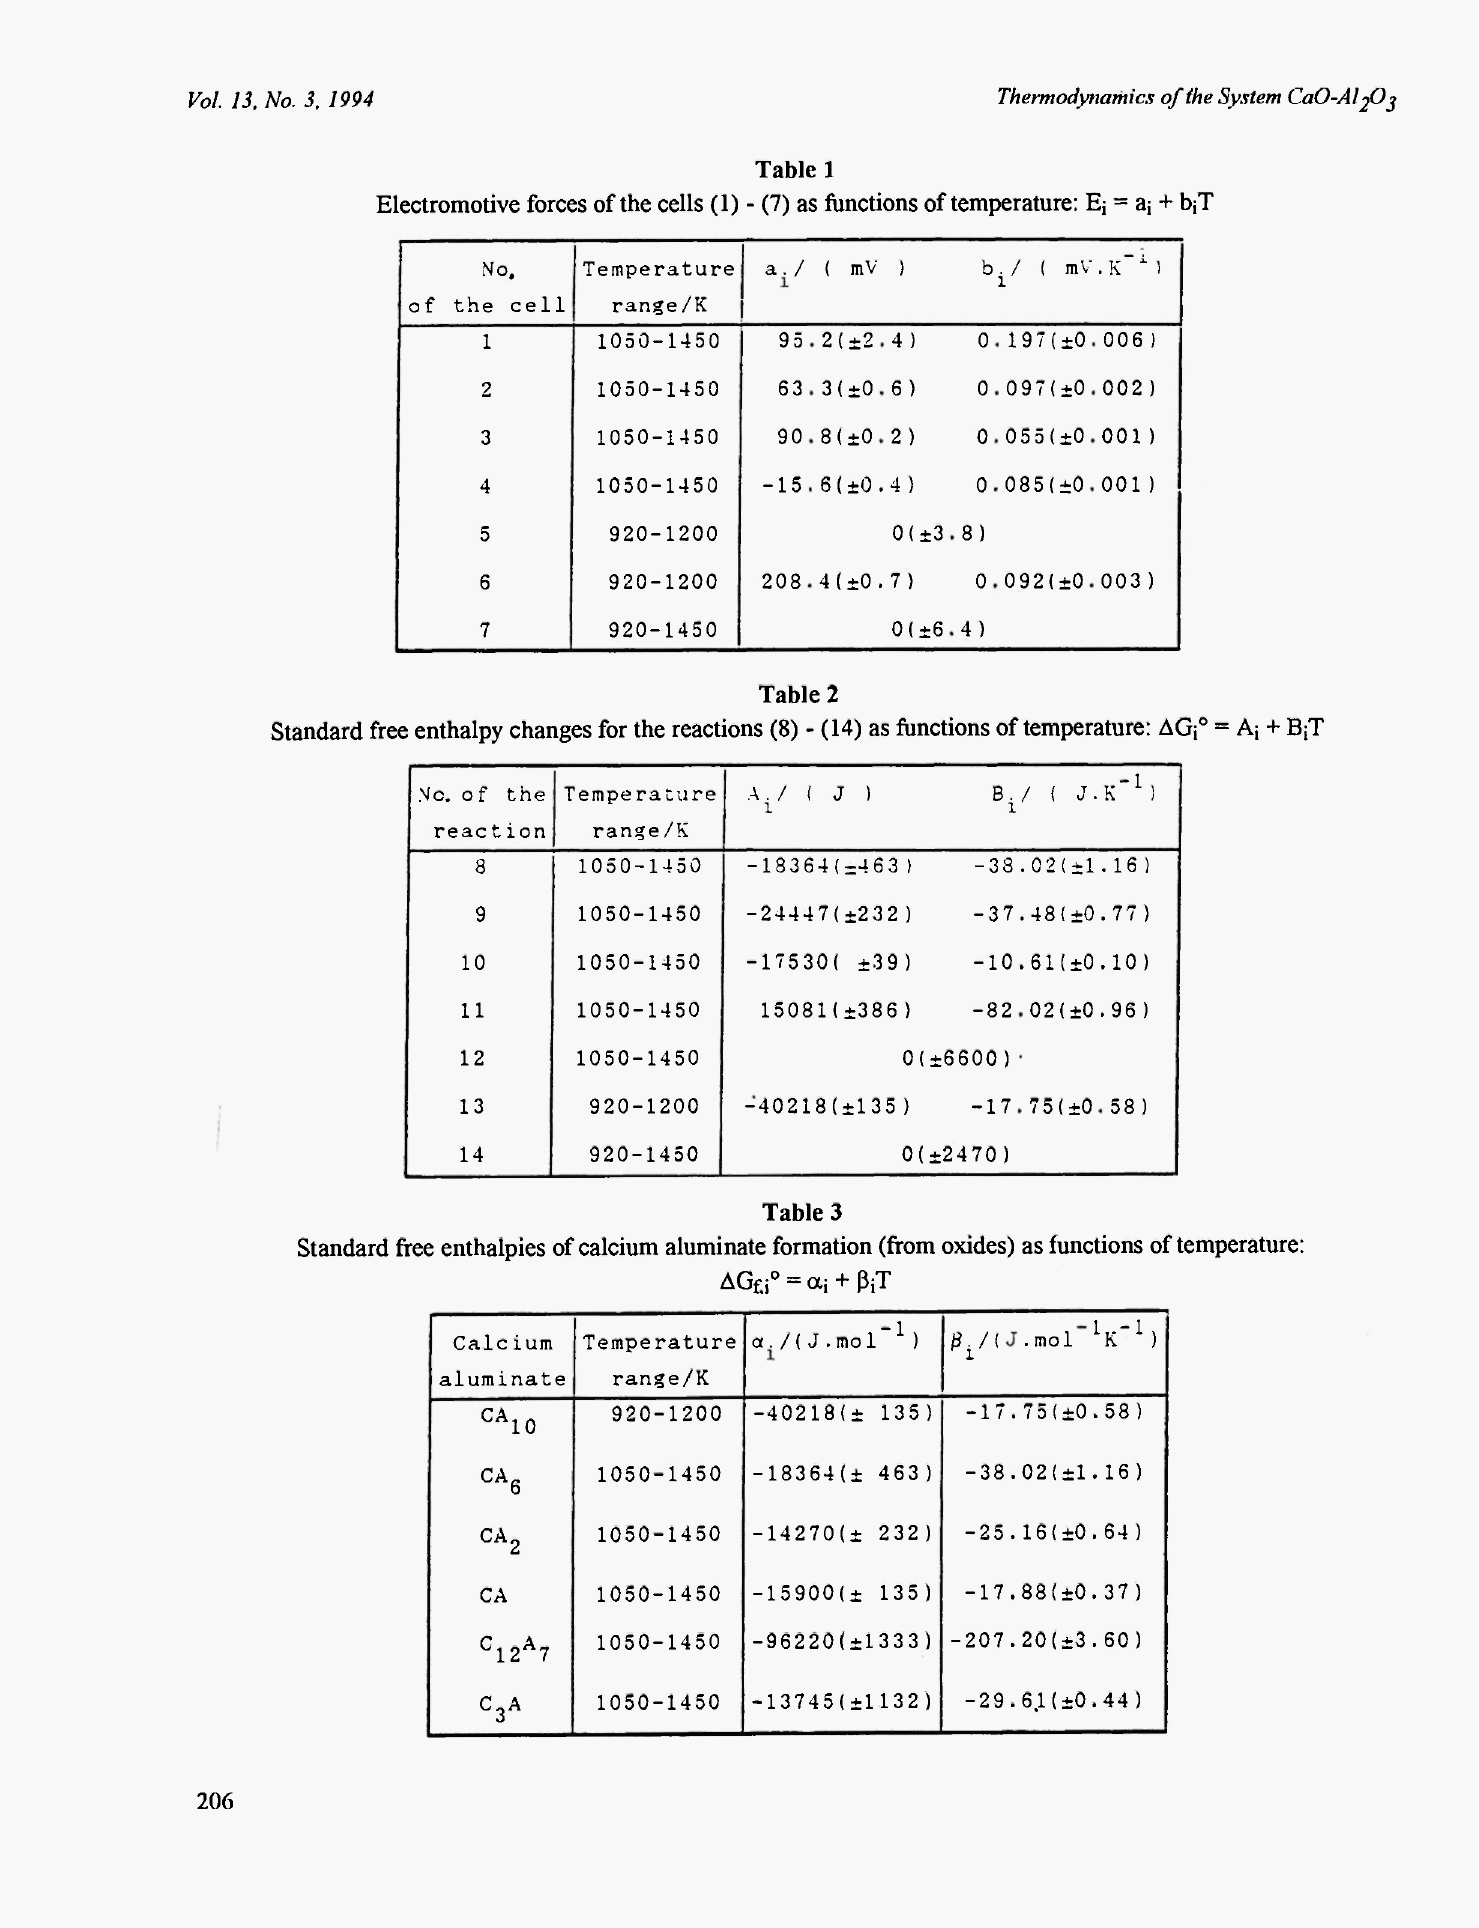
Standard free enthalpies of calcium aluminate formation (from oxides) as functions of